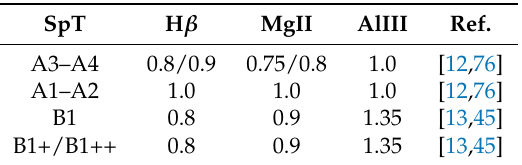
Table 1. The LIL and IIL ξ (Equation 2) factor for the spectral types of the quasar MS, listed for the spectral types (SpT) of highest occupation. SpT H β MgII AlIII